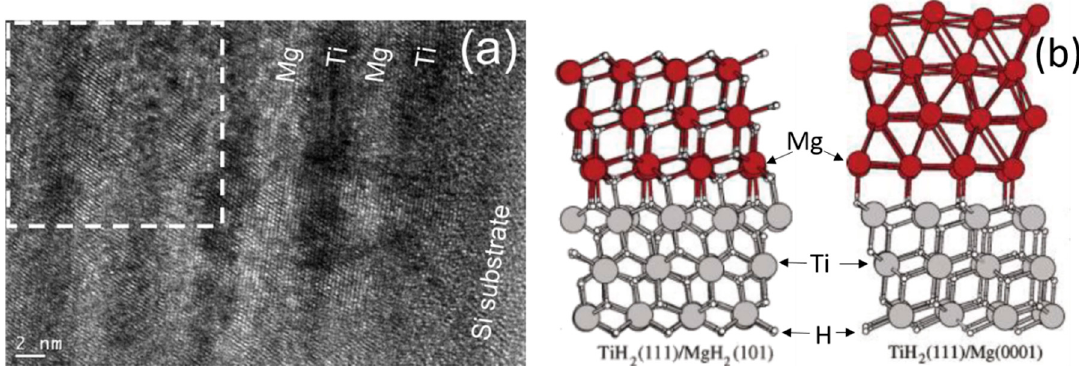
Figure 8. ( a ) Cross-section TEM image of a Mg(4 nm) / Ti(2 nm) multilayer. The dashed rectangle highlights the presence of structural coherence at the interface between layers. Reprinted with permissions from [96] (copyright 2010 The American Physical Society). ( b ) Calculated structure of the TiH 2 (111) / MgH 2 (101) interface (left) and of the TiH 2 (111) / Mg(0001) (right). Reprinted with permissions from [51] (copyright 2012 American Chemical Society).